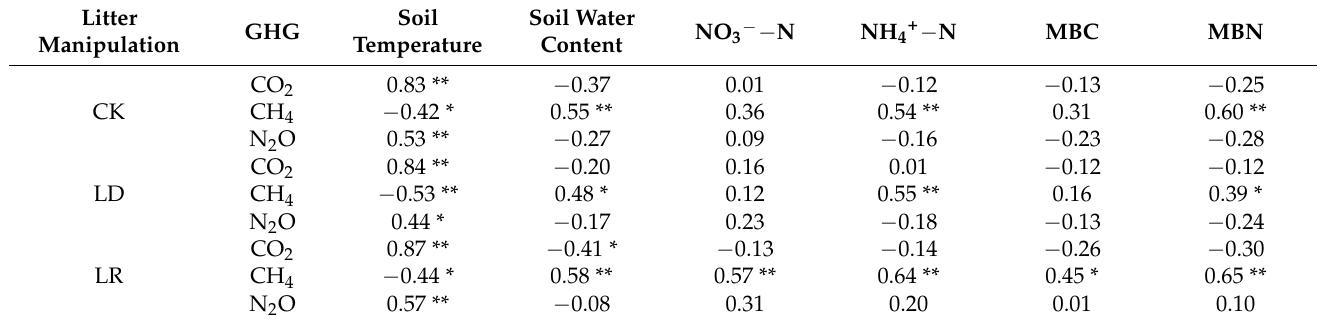
Table 2. Correlations of soil GHG fluxes with soil NO 3 − -N, NH 4+ -N, MBC, and MBN contents measured under different litter manipulation treatments (* p < 0.05; ** p < 0.01). Litter manipulation treatment abbreviations: CK, unchanged litter input; LD, doubled litter; LR, litter removal.